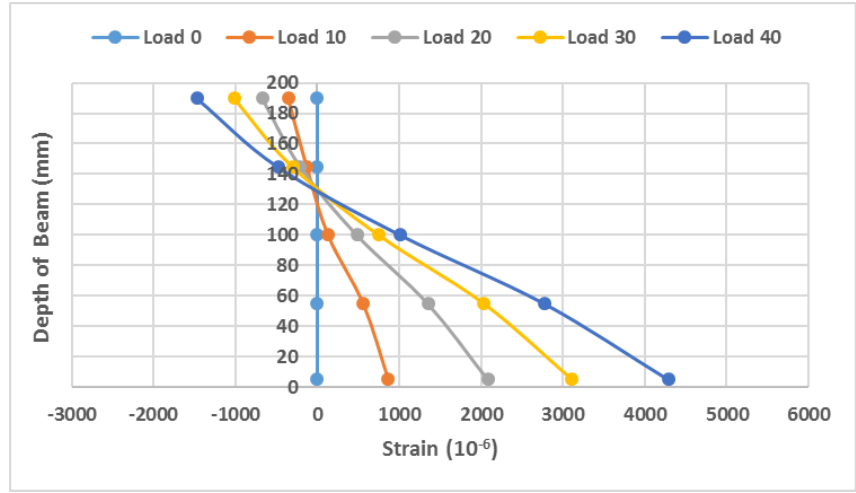
Figure 10. Depth of neutral axis for CC.